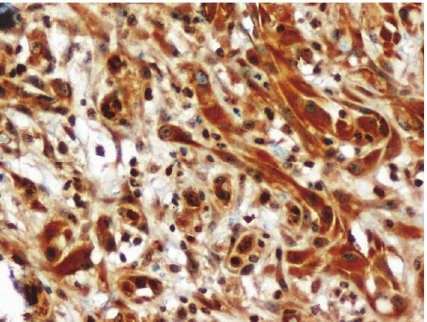
Figure 5: CD34 immunostaining × 400. An intense expression of CD34 by the endothelial cells and the epithelioid